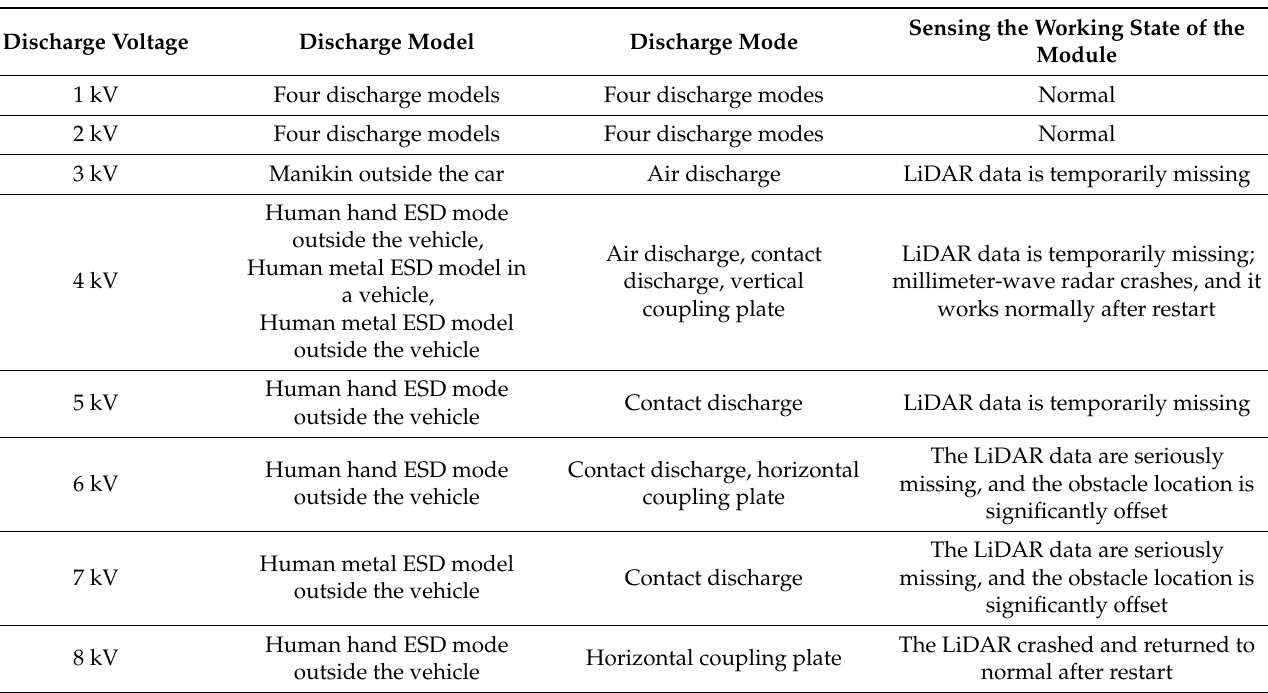
Table 4. Experimental data of sensing